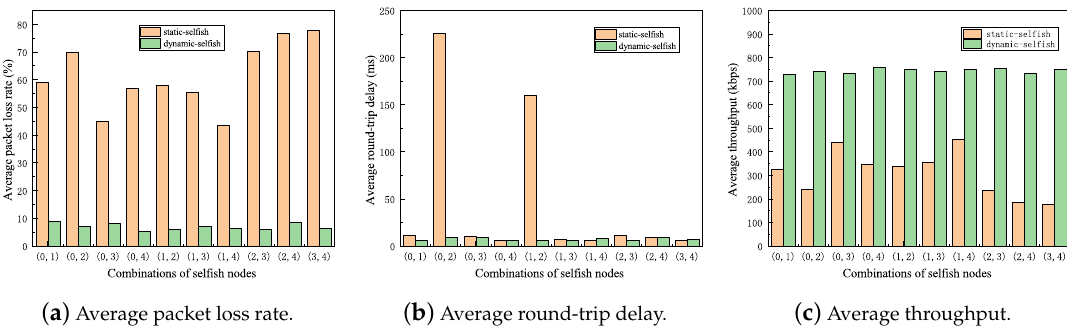
Figure 11. Performance impact of different combinations of selfish nodes following the same mobility model (5 nodes). Every node has the same mobility in each run, but there are different selfish node